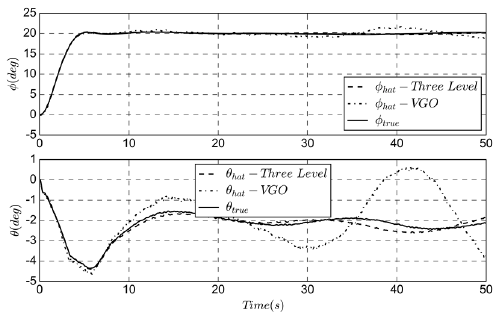
Figure 5. Comparison of true and estimated roll and pitch angle.